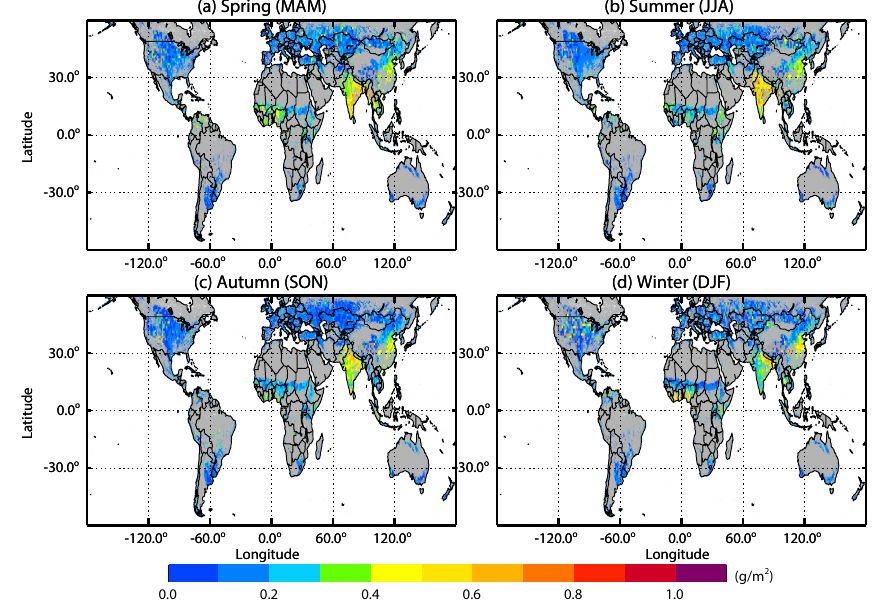
Figure 6. Global seasonal distributions of mean anthropogenic dust column burden (2007–2010) for spring–winter, (a) – (d) , respectively. The gray areas represent non-anthropogenic dust source over land.